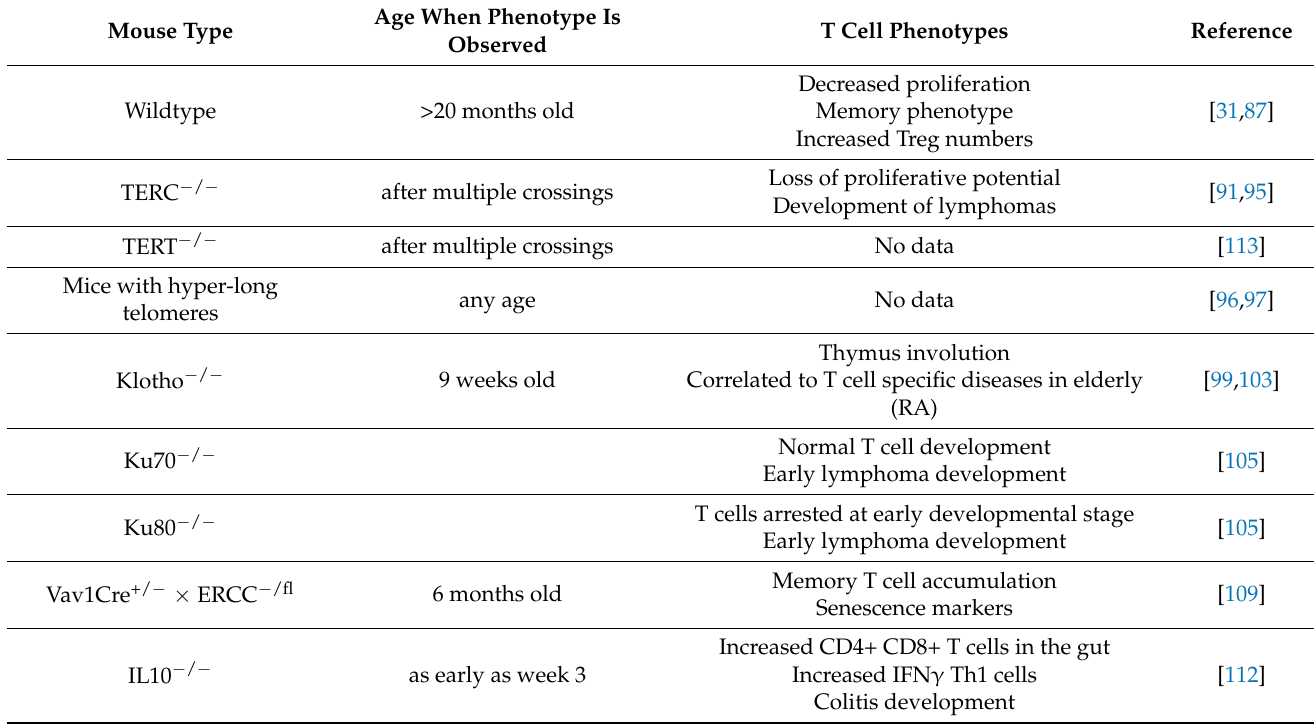
Table 2. Premature T cell aging in mouse